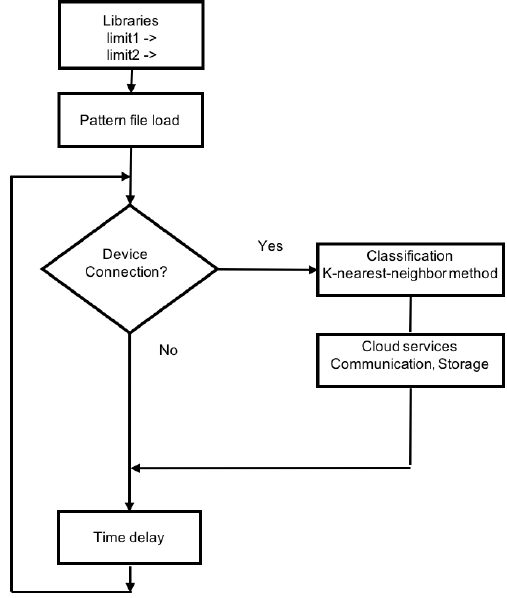
Figure 20. Device classification using K-nearest-neighbor.